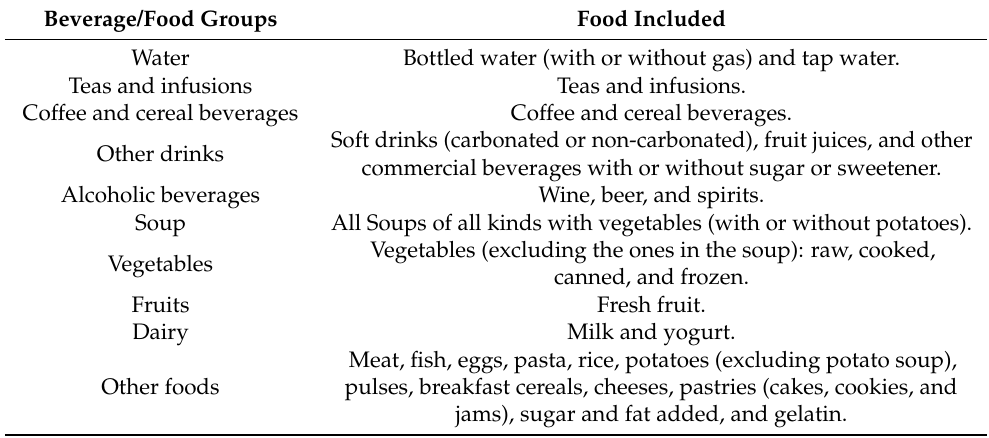
Table 1. Food and beverage groups created to estimate the contribution of food groups to total water intake.